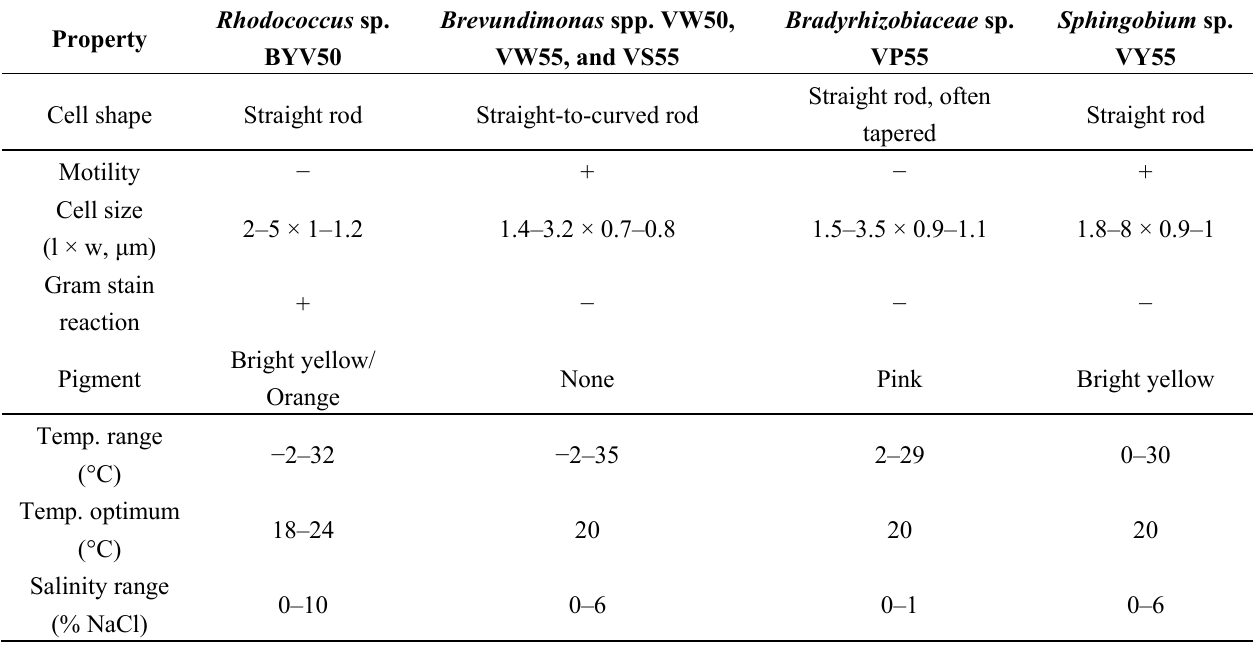
Table 1. Summary of major properties of Lake Vanda bacteria isolated in this study a .